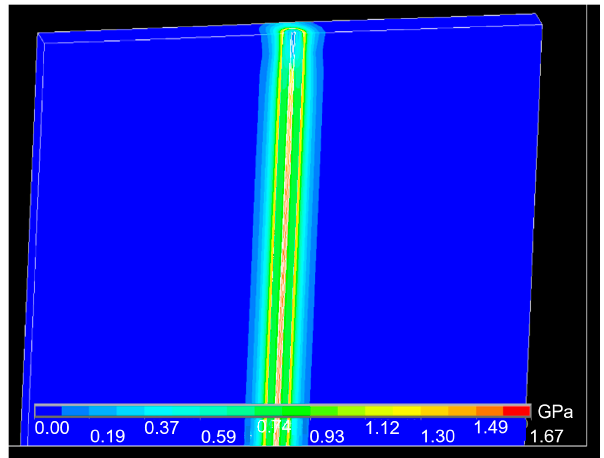
Figure 5. Distribution of the compressive residual thermal stress after the temperature decreases from the melting point to room temperature.